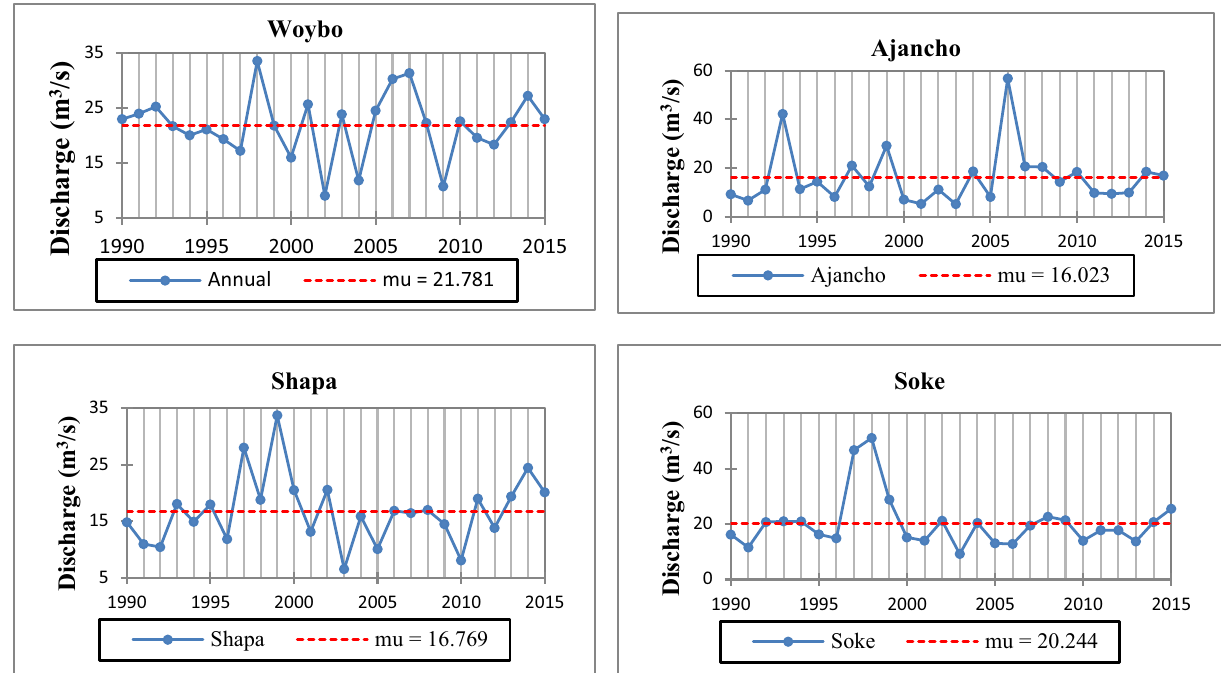
Fig. 4 Homogeneity test of the annual mean discharge at four stations, where mu is the annual mean discharge